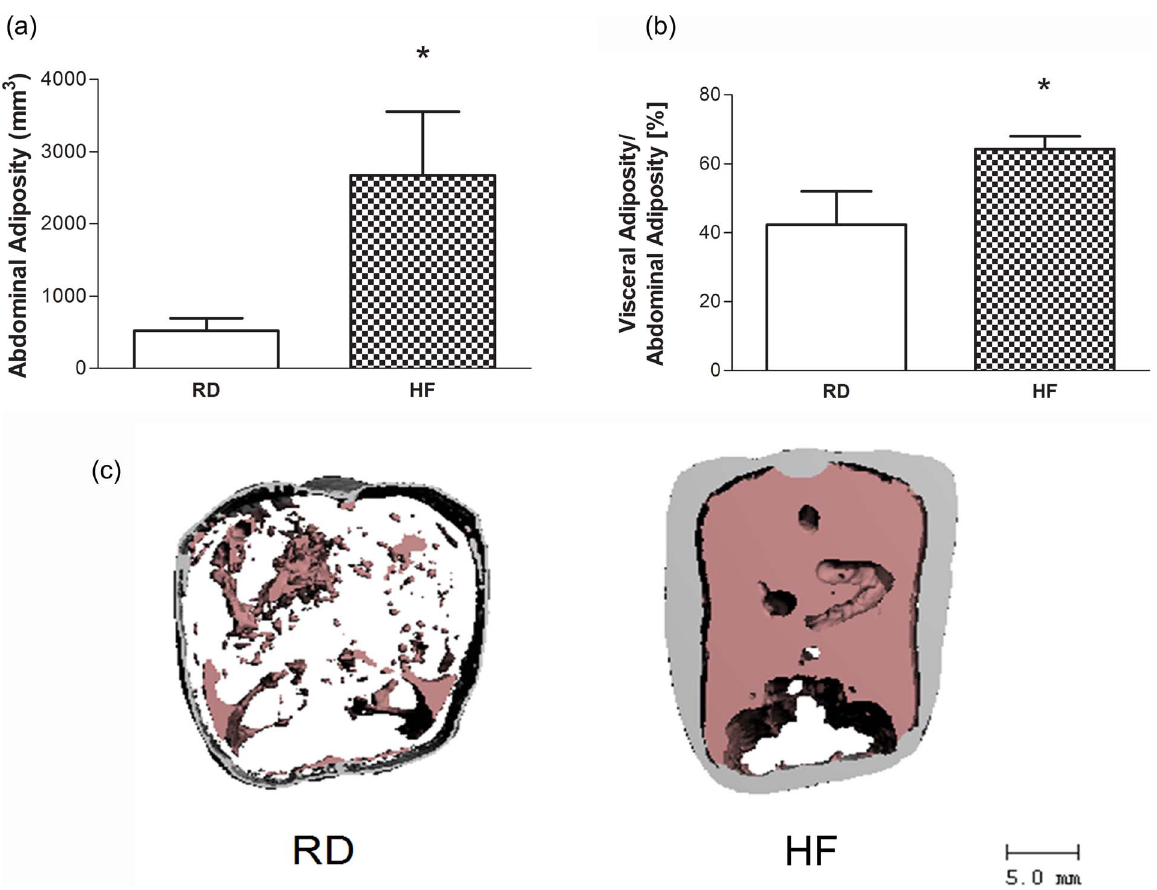
Figure 1. High Fat Diet Induces an Obese Phenotype. (a,b) At 6 weeks HF animals have expanded total abdominal adiposity with a prominent shift in the location of this adiposity from primarily subcutaneous to the visceral compartment. (c) The expansion and relocation of adiposity is illustrated in 3D reconstructions of abdominal m CT images which have been thresholded for adiposity (n=9). In these images gray represents subcutaneous fat and pink represents visceral fat. * P , 0.05 vs. RD.